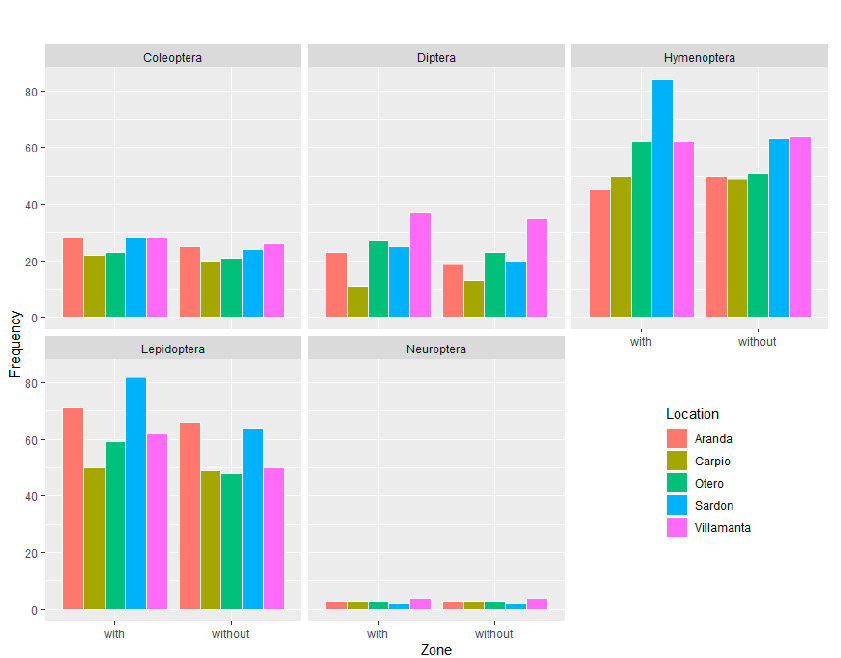
Figure 1. The abundance of genera by locality and treatment zone by insect